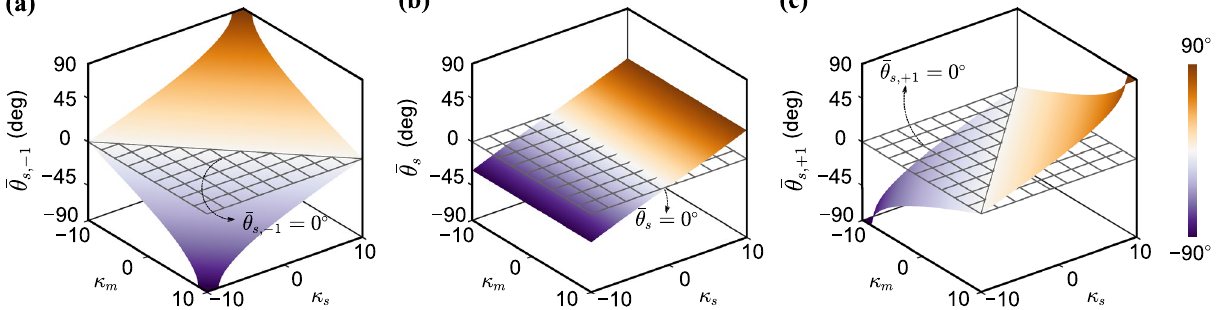
Figure 4. Effect of changing κ m and κ s on the three principal listening directions: ( a ) ¯ θ s ,